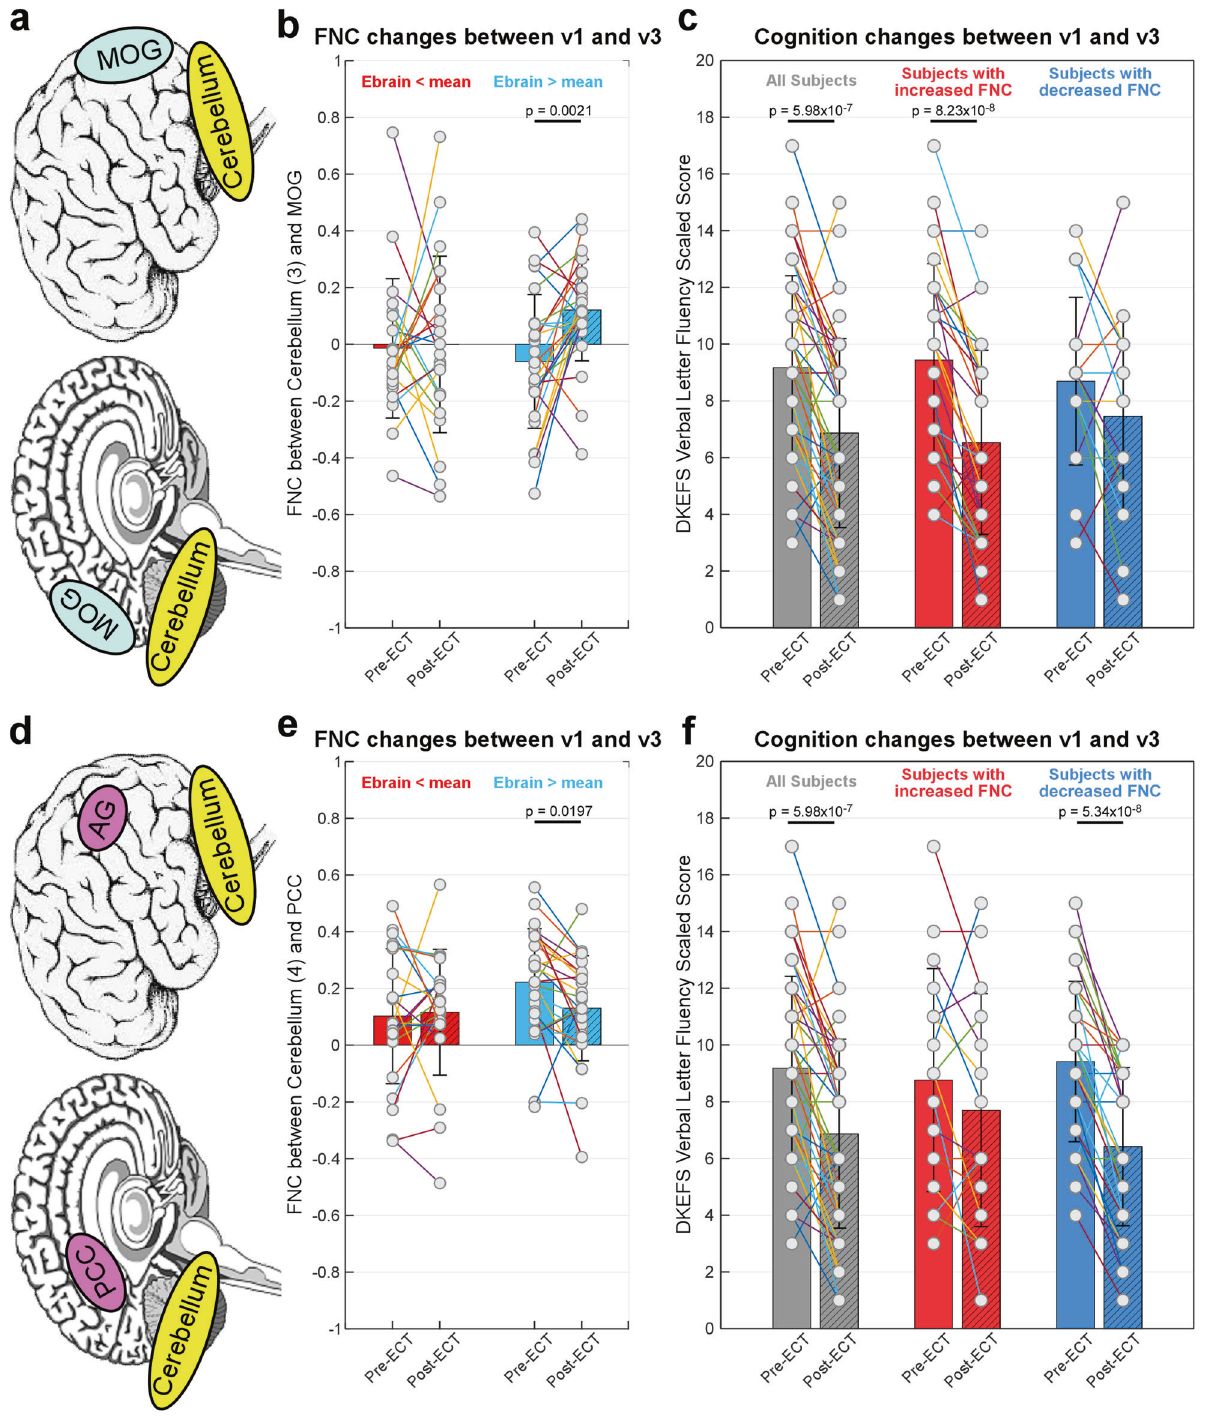
Fig. 5 E brain related cerebro-cerebellar FNC neuroplasticity can predict ECT induced cognitive impairment. a Δ FNC between cerebellum and MOG is associated with E brain and cognitive side-effects. b Subjects with large E brain tend to have increased cerebellum-MOG FNC. c Increased cerebellum-MOG FNC results in a decrease of DKEFS Verbal Fluency - Letter Fluency. d Δ FNC between cerebellum and PCC is associated with E brain and cognitive side-effects. e Subjects with large E brain tend to have decreased cerebellum-PCC FNC. f Decreased cerebellum-PCC FNC results in a decrease of DKEFS Verbal Fluency - Letter Fluency. E brain the 90 th percentile of electric fi eld magnitude in the brain, FNC functional network connectivity, ECT electroconvulsive therapy, MOG middle occipital gyrus, DKEFS Delis Kaplan Executive Function System, PCC posterior cingulate cortex.